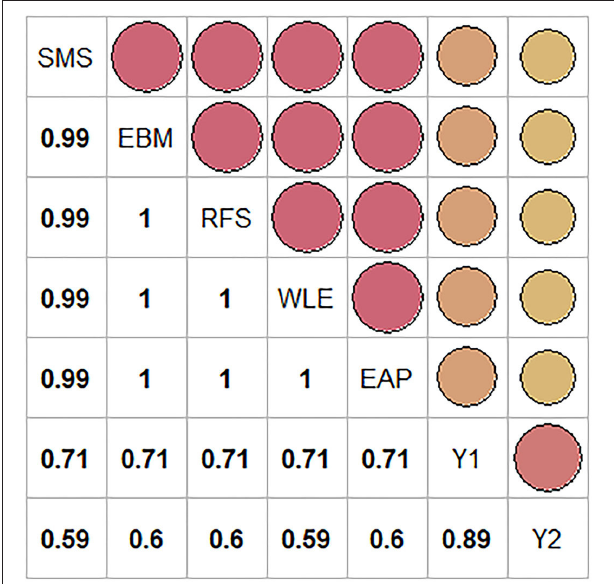
FIGURE 2 | Correlation plot of the five types of test scores-SMS, EBM, RFS, WLE, and EAP, and the two outcomes - Y 1 and Y 2 . The size and color of the dots in the plot represent the strength of the correlation. Bigger the dots, higher the